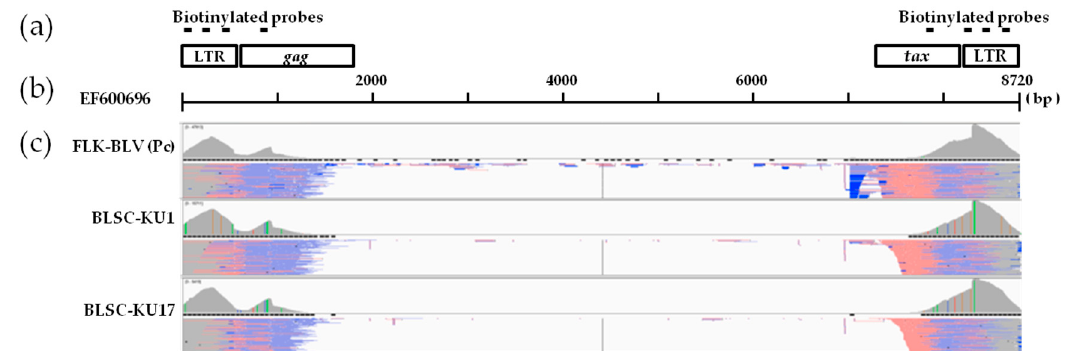
Figure 3. Visualization of paired-end short read sequences mapped to the BLV reference FLK-BLV sequence (EF600696). ( a ) The schematic structure of the biotinylated probe targeting region. Horizontal lines indicate biotinylated probes. ( b ) The schematic length of the BLV reference FLK-BLV sequence (EF600696). ( c ) The visualization of the mapping of paired-end reads of positive control FLK-BLV, and BLSC-KU1 and BLSC-KU17 cell lines obtained using next-generation sequencing.